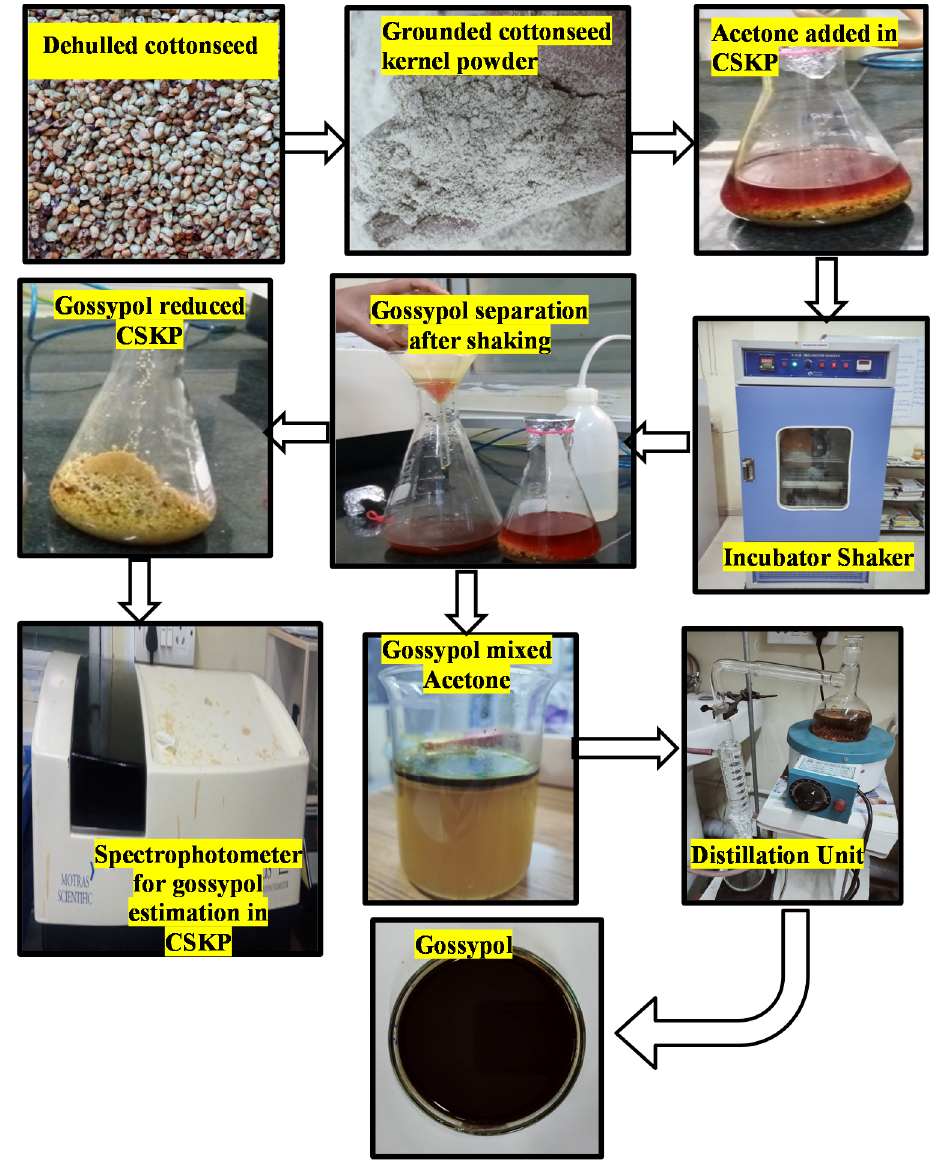
Figure 2. Schematic layout of process of gossypol extraction from cottonseed used in this study.